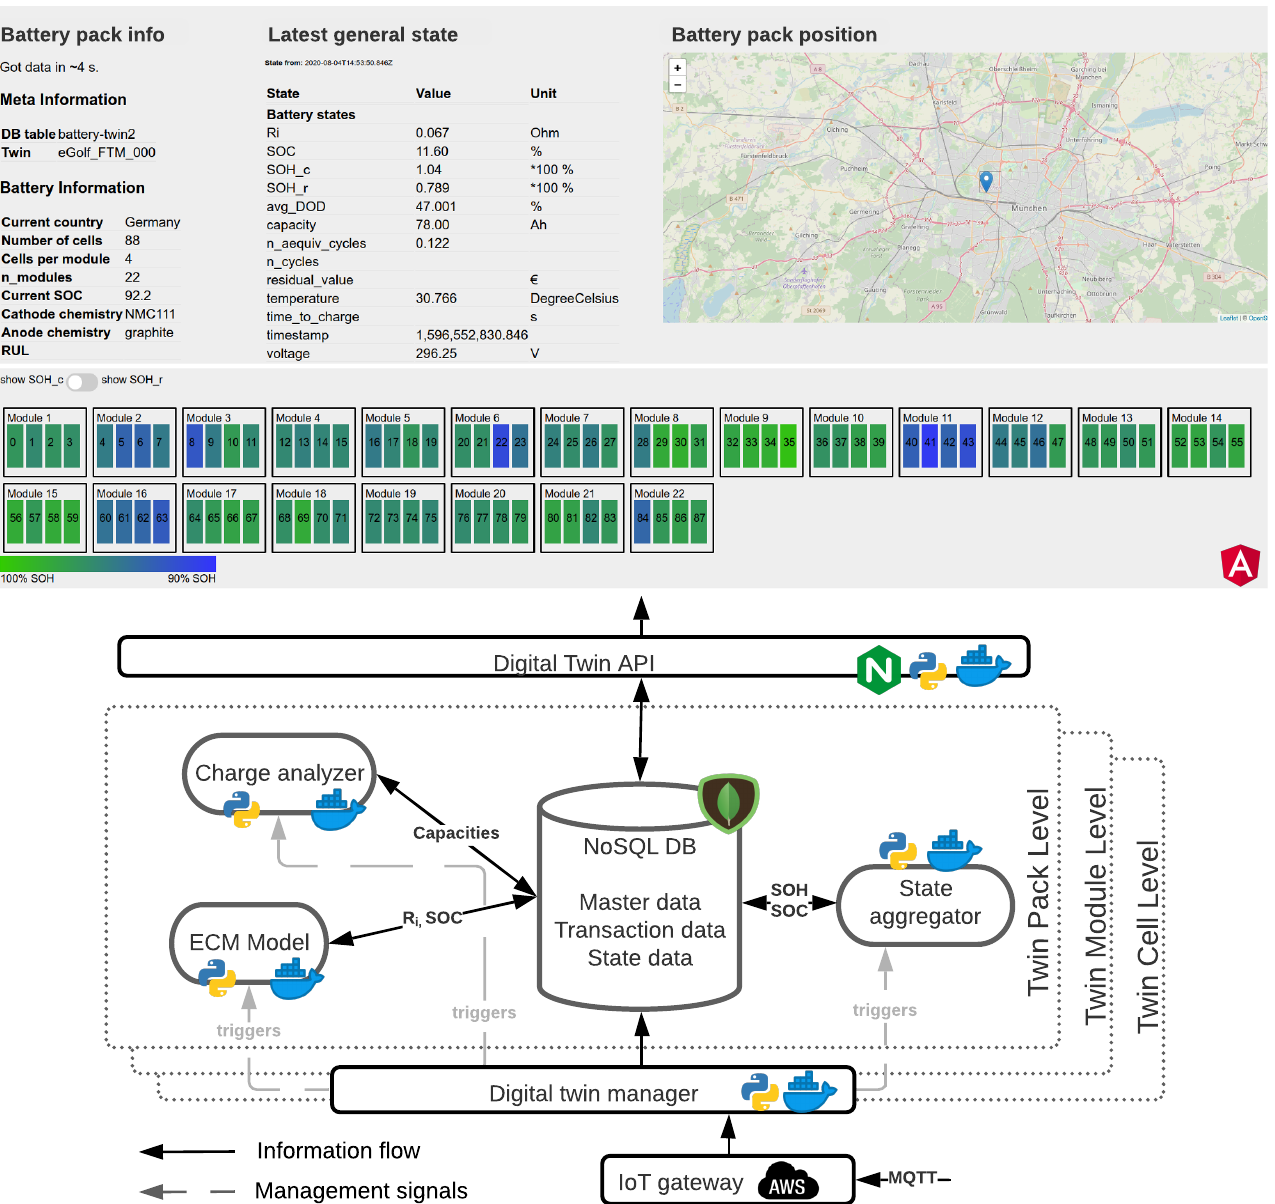
Figure 14. Architecture of the digital twin system. For this work, the system was hosted in the AWS cloud. Individual twins share the same resources as models, aggregators and APIs. In the upper part, the front end shows the results to the user. In total, 88 cell-blocks consisting of three parallelly connected cells can be